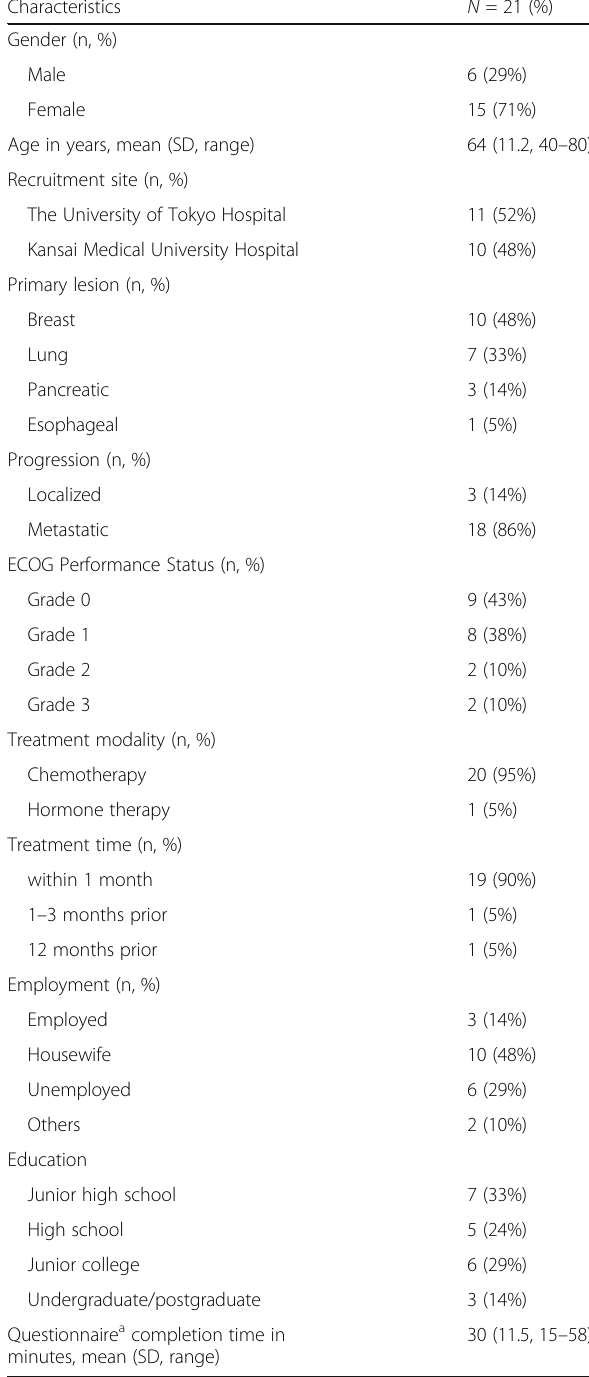
Table 1 Patient